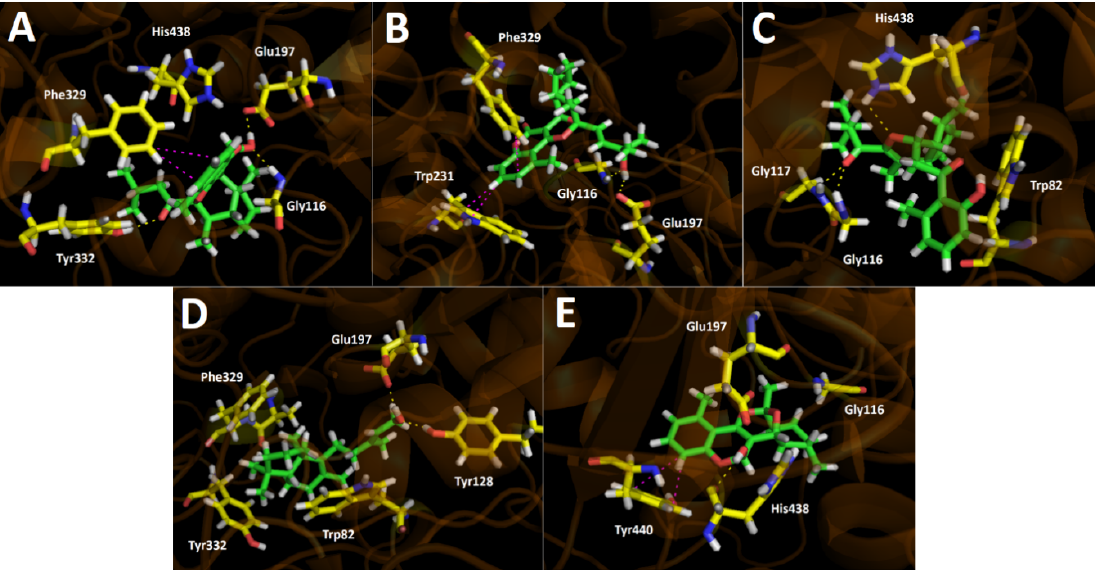
Figure 7. Predicted binding mode and predicted intermolecular interactions of selected major metabolites from the Gypothamnium pinifolium n -hexane and ethyl acetate extracts and the residues of human butyrylcholinesterase ( h BChE) catalytic site. Yellow dotted lines indicate hydrogen bond interactions, and magenta dotted lines represent T-shaped interactions. ( A ) Cyclolycoserone in the catalytic site; ( B ) 8-epi-gypothaminol in the catalytic site; ( C ) 2- nor -1,2-secolycoserone in the catalytic site; ( D ) Ent -labda-8,13- E -diene-15-ol in the catalytic site; ( E ) 6-hydroxyaphyllodenticulide in the catalytic